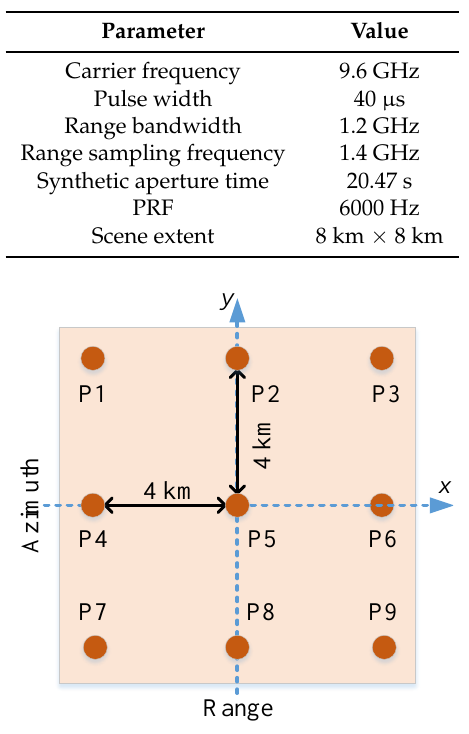
Figure 4. The point target array in simulation experiment.